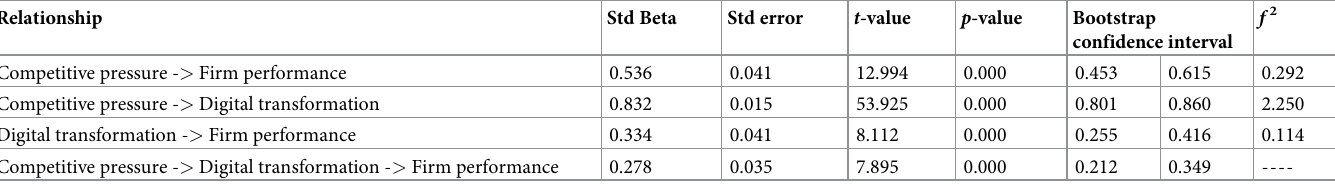
Table 6. The assessment of structural model.